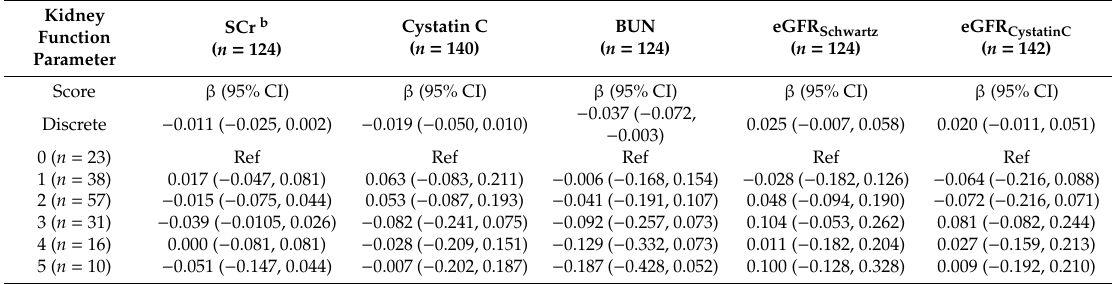
Table 5. Association between estimated cumulative dietary Cd score (as a discrete and categorical variable) and 9-year kidney function parameters a